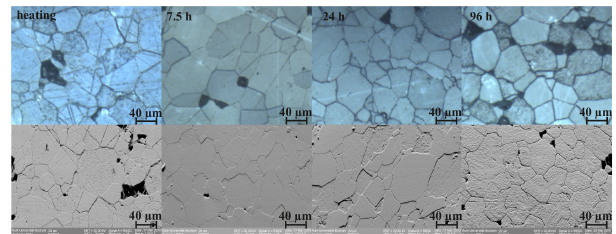
Figure 2. Sample surfaces as observed with a light microscope (top row) and SEM (bottom row) for samples annealed at 392 ◦ C for 7.5, 24, and 96h. The images labeled heating show a sample that expe- rienced heating up to 568 ◦ C at 200MPa and immediate cooling.